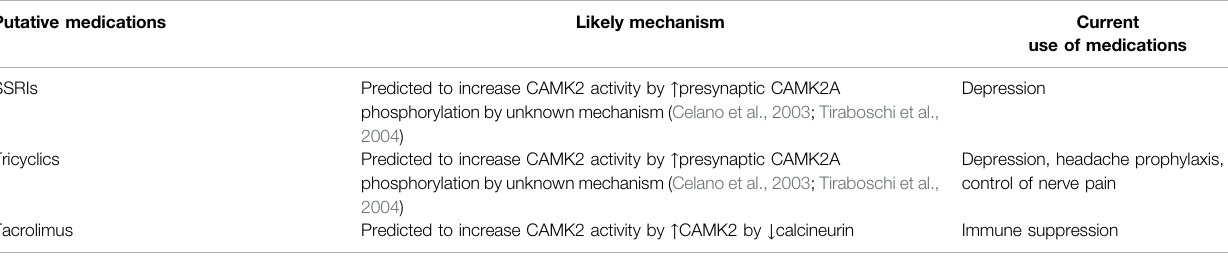
Table1Eachmedication ’ sactiononCAMK2ishypothesizedbyauthorsbasedonknownmechanisms.Labels:Alphabeticlabelsrefertothesiteofproposedactivitydepictedin Figure2 . Abbreviations: ROS, reactive oxygen species; GABA-AR, GABA-A receptor; GABA-BR, GABA-B receptor; Ca++, calcium; NOS, nitric oxide species; RyR, ryanodine receptor; Na+, sodium; CICR, calcium initiated calcium release.